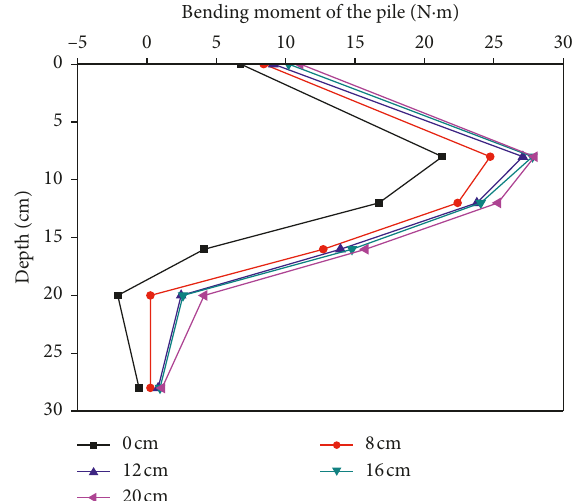
SCSC_zone values.